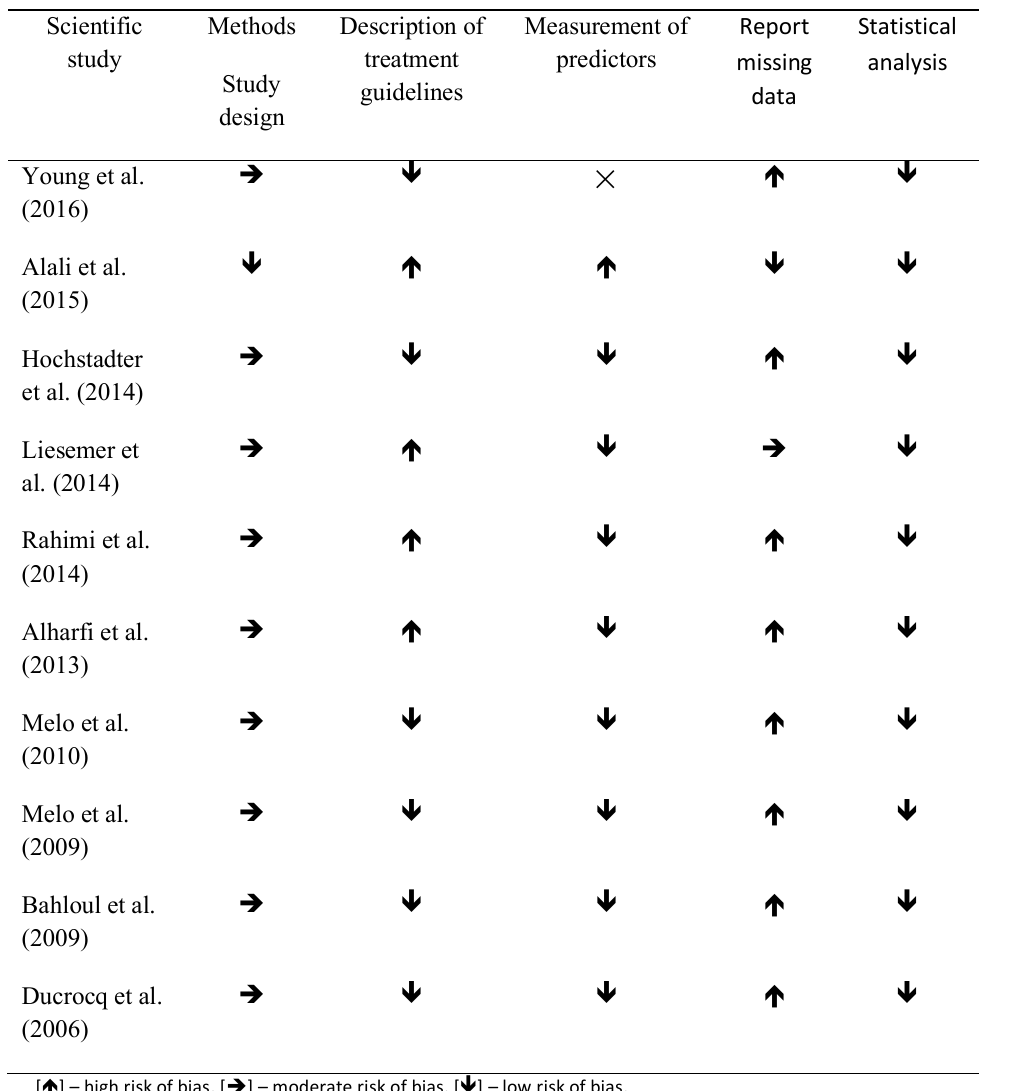
Table 1- Risk of bias for each scientific study included in the final sample, according each domain, based on CHARMS (Critical Appraisal and Data Extraction for Systematic Reviews of Prediction Modelling Studies) for this Systematic